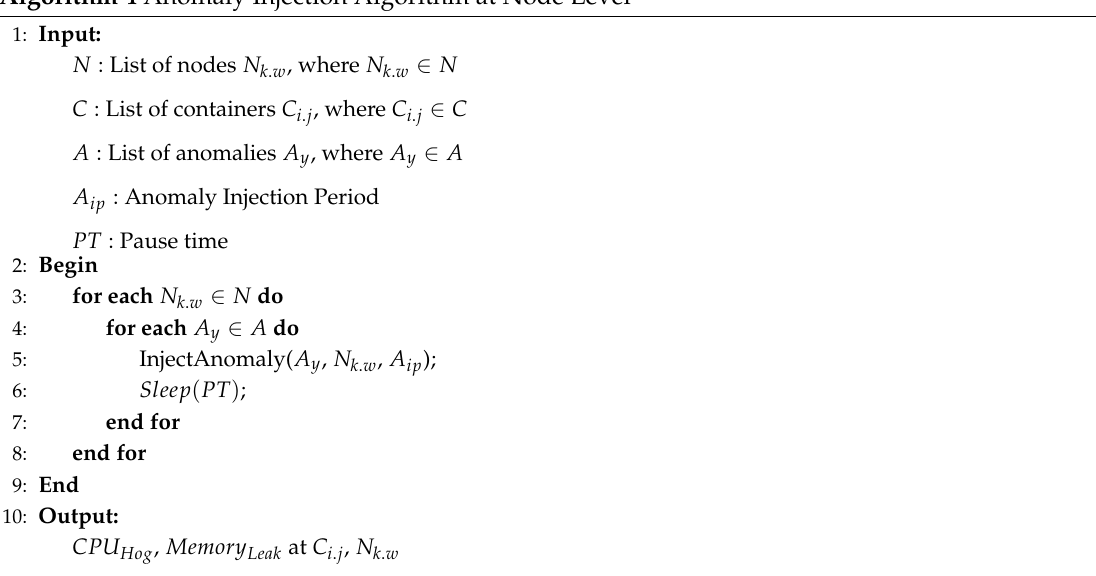
Algorithm 4 Anomaly Injection Algorithm at Node